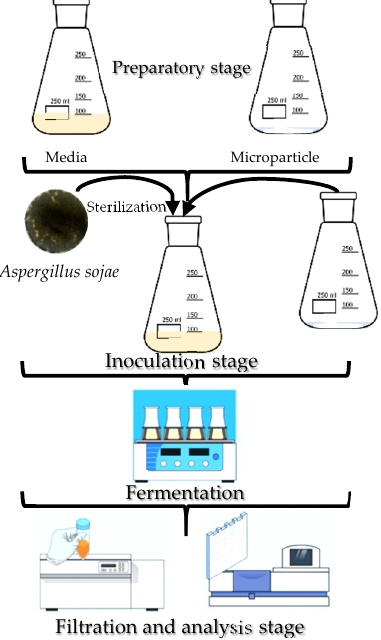
Figure 1. Microparticle usage strategy for shake flask fermentations.